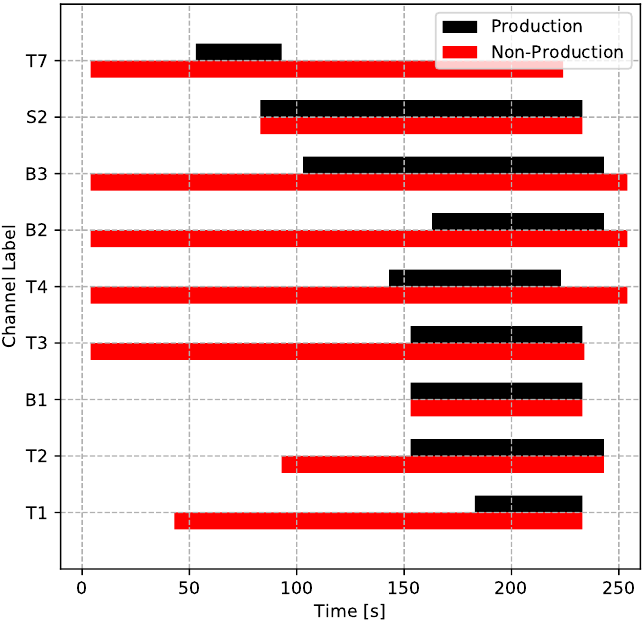
Figure 17. Cooling timing of the two process